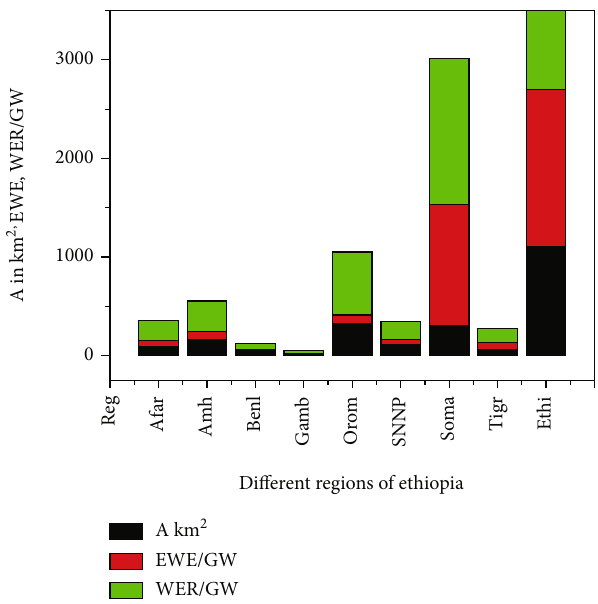
Figure 13: Wind energy resource of Afar region and Ethiopia. A: area; EWE: energy of wind potential; WER: wind energy reserve.